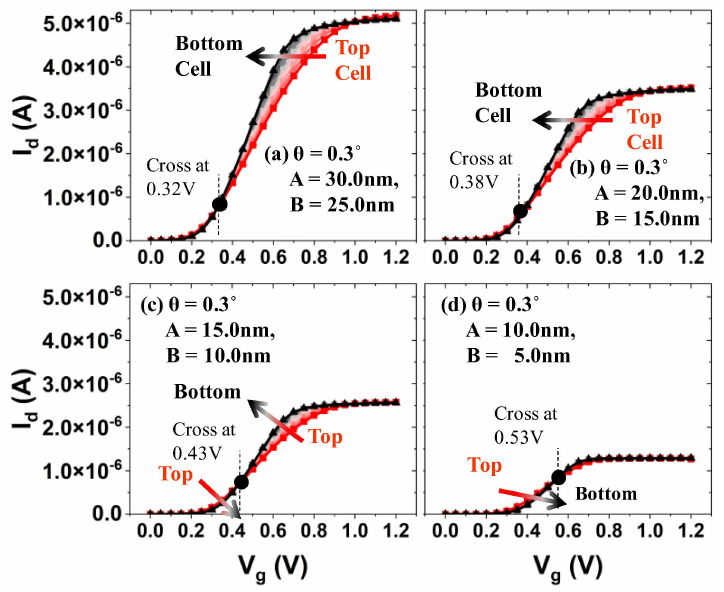
Figure 5. ( a – d ) Simulated I d vs. V g for the bit cells (from top to bottom), when those cells in a string are scaled down together in